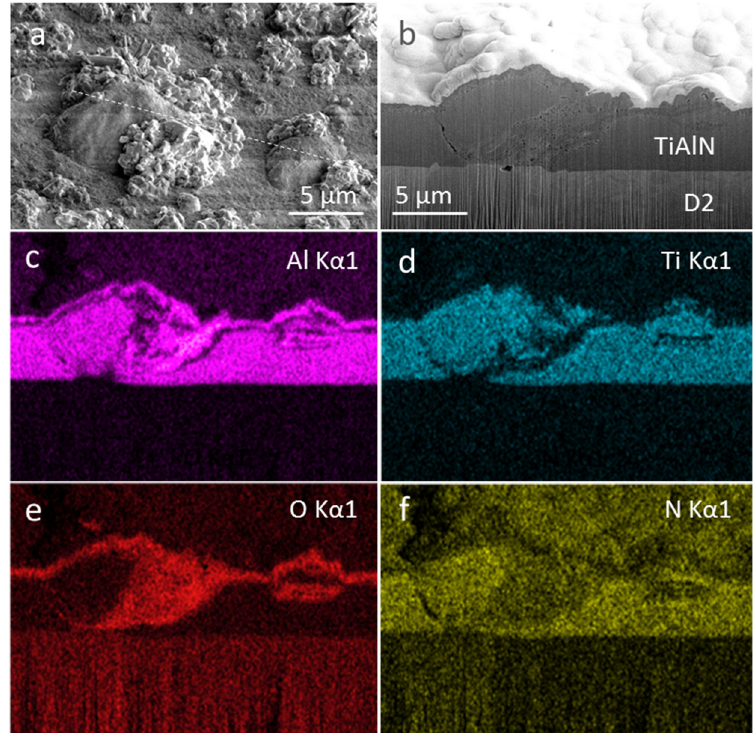
Figure 13. SEM images of nodular defect in sputter-deposited TiAlN hard coating oxidized at 850 °C for 60 min: ( a ) SEM image, ( b ) SEM image of FIB cross-section of the same defect, and ( c – f ) corresponding elemental maps.